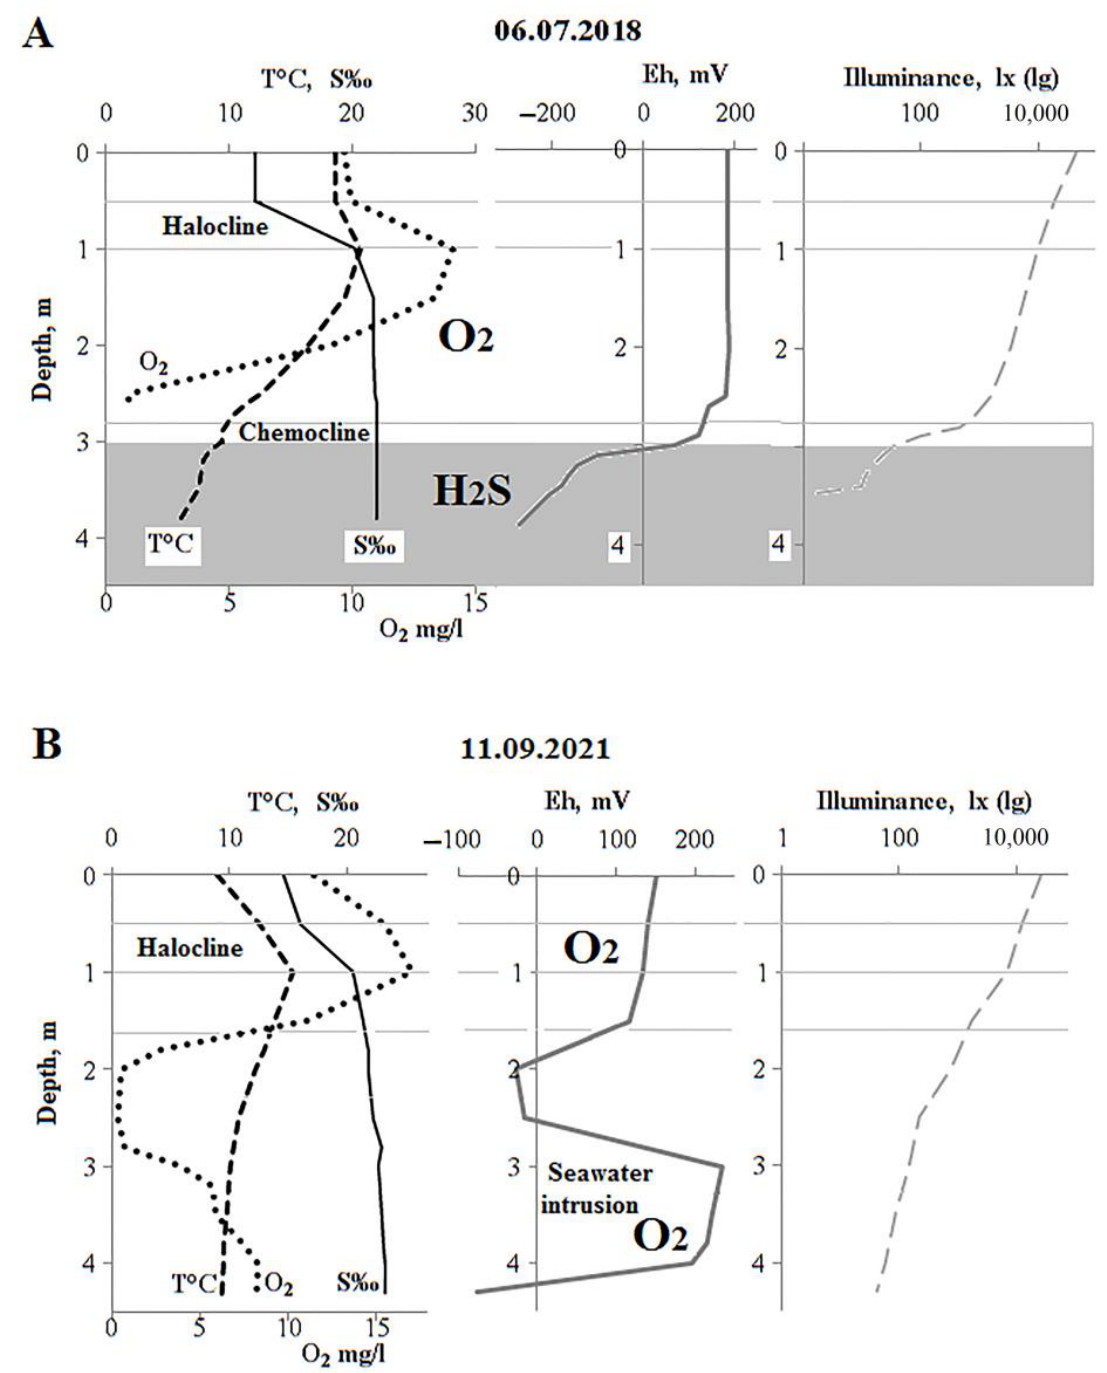
Figure 1. Vertical hydrological, hydro-chemical (O 2 concentration, Eh), and hydro-physical profiles (temperature, salinity, illuminance) in Lake Kislo-Sladkoe on 6 July 2018 ( A ) and 11 September 2021 ( B ).